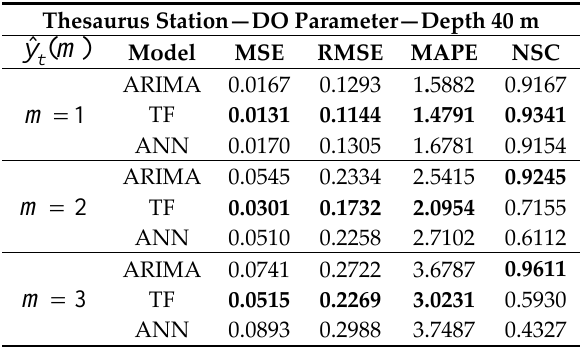
Table 3. Statistical parameters for comparison of observed and predicted values using ARIMA, TF and ANN models and m = 1, 2 and 3 (40 m depth).